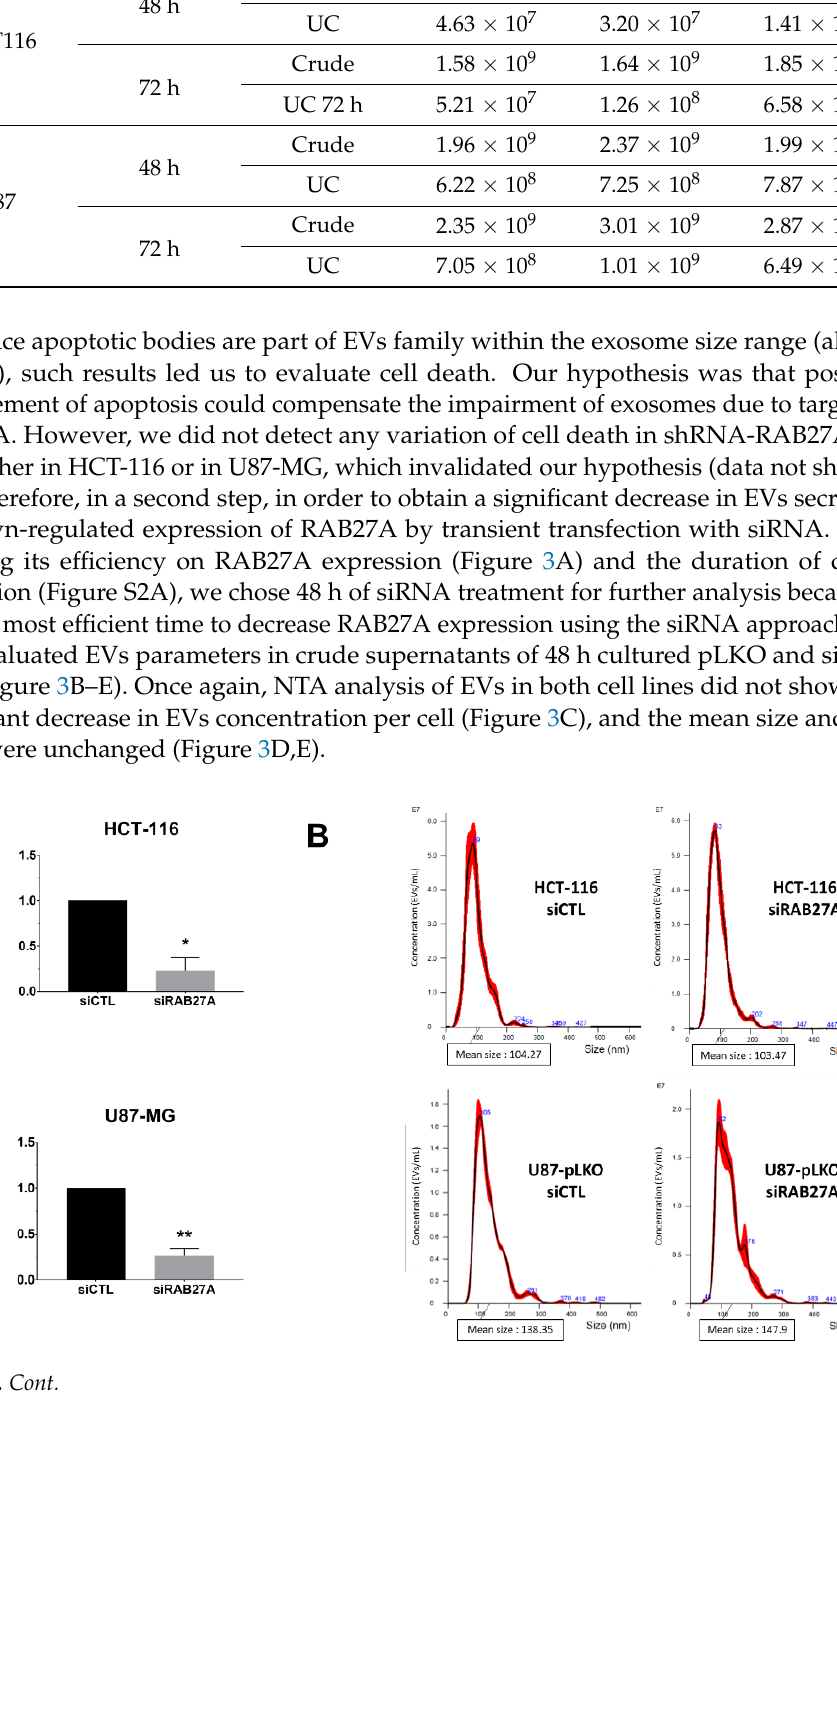
Table 1. EVs NTA-estimated concentration for each condition in each cell line according to the dif- ferent culture times (UC: Ultracentrifugation).